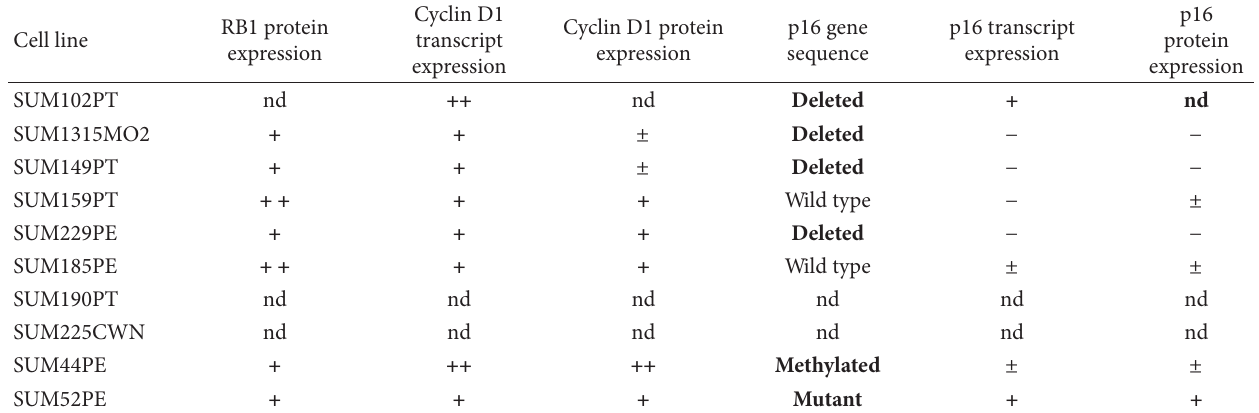
T 4: Mutational analysis Rb pathway genes for Asterand SUM cell lines.